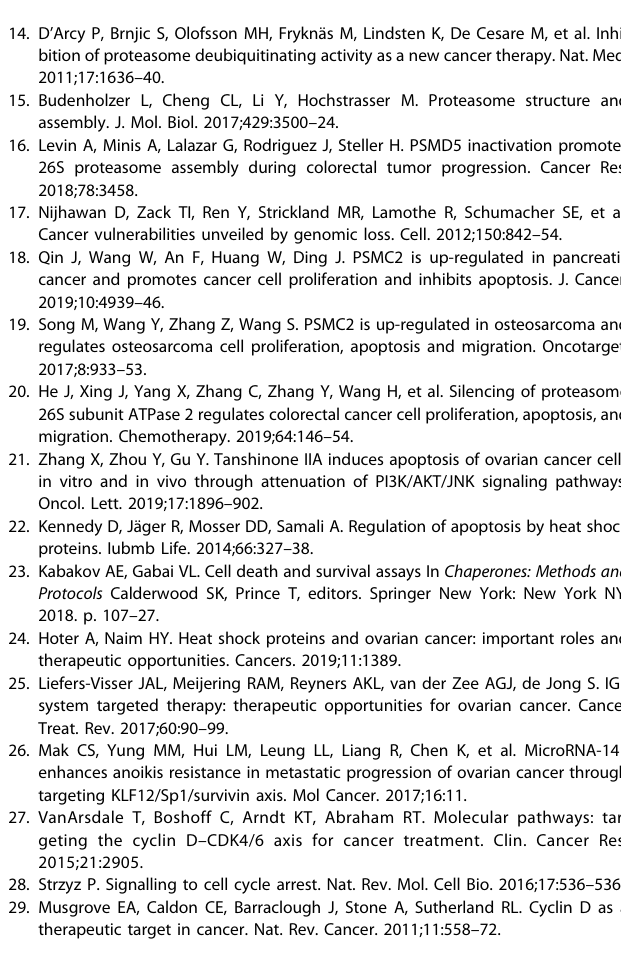
Fig. 6 Knockdown of PSMC2 and CCND1 synergistically inhibits ovarian cancer development in vitro. A MTT assay was applied to evaluate the impacts of CCND1 knockdown alone or PSMC2 and CCND1 knockdown together on HO-8910 cell proliferation. B The effects of CCND1 knockdown alone or PSMC2 and CCND1 knockdown together on colony formation ability of HO-8910 cells were assessed. C The regulation of cell apoptosis by CCND1 knockdown alone or PSMC2 and CCND1 knockdown together was detected by fl ow cytometry. Wound-healing ( D ) and transwell ( E ) assays were utilized for determining the impacts of CCND1 knockdown alone or PSMC2 and CCND1 knockdown together on cell migration. Data were presented as mean ± standard deviation based on at least 3 independent experiments. ** P < 0.01, *** P <